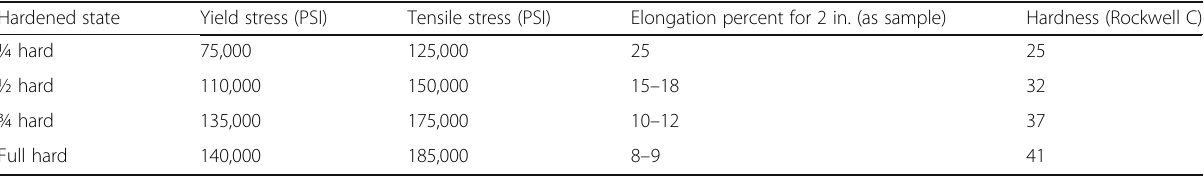
Table 5 Various states of the work hardening of stainless steel 301 (AK Steel Corporation 2007) Hardened state